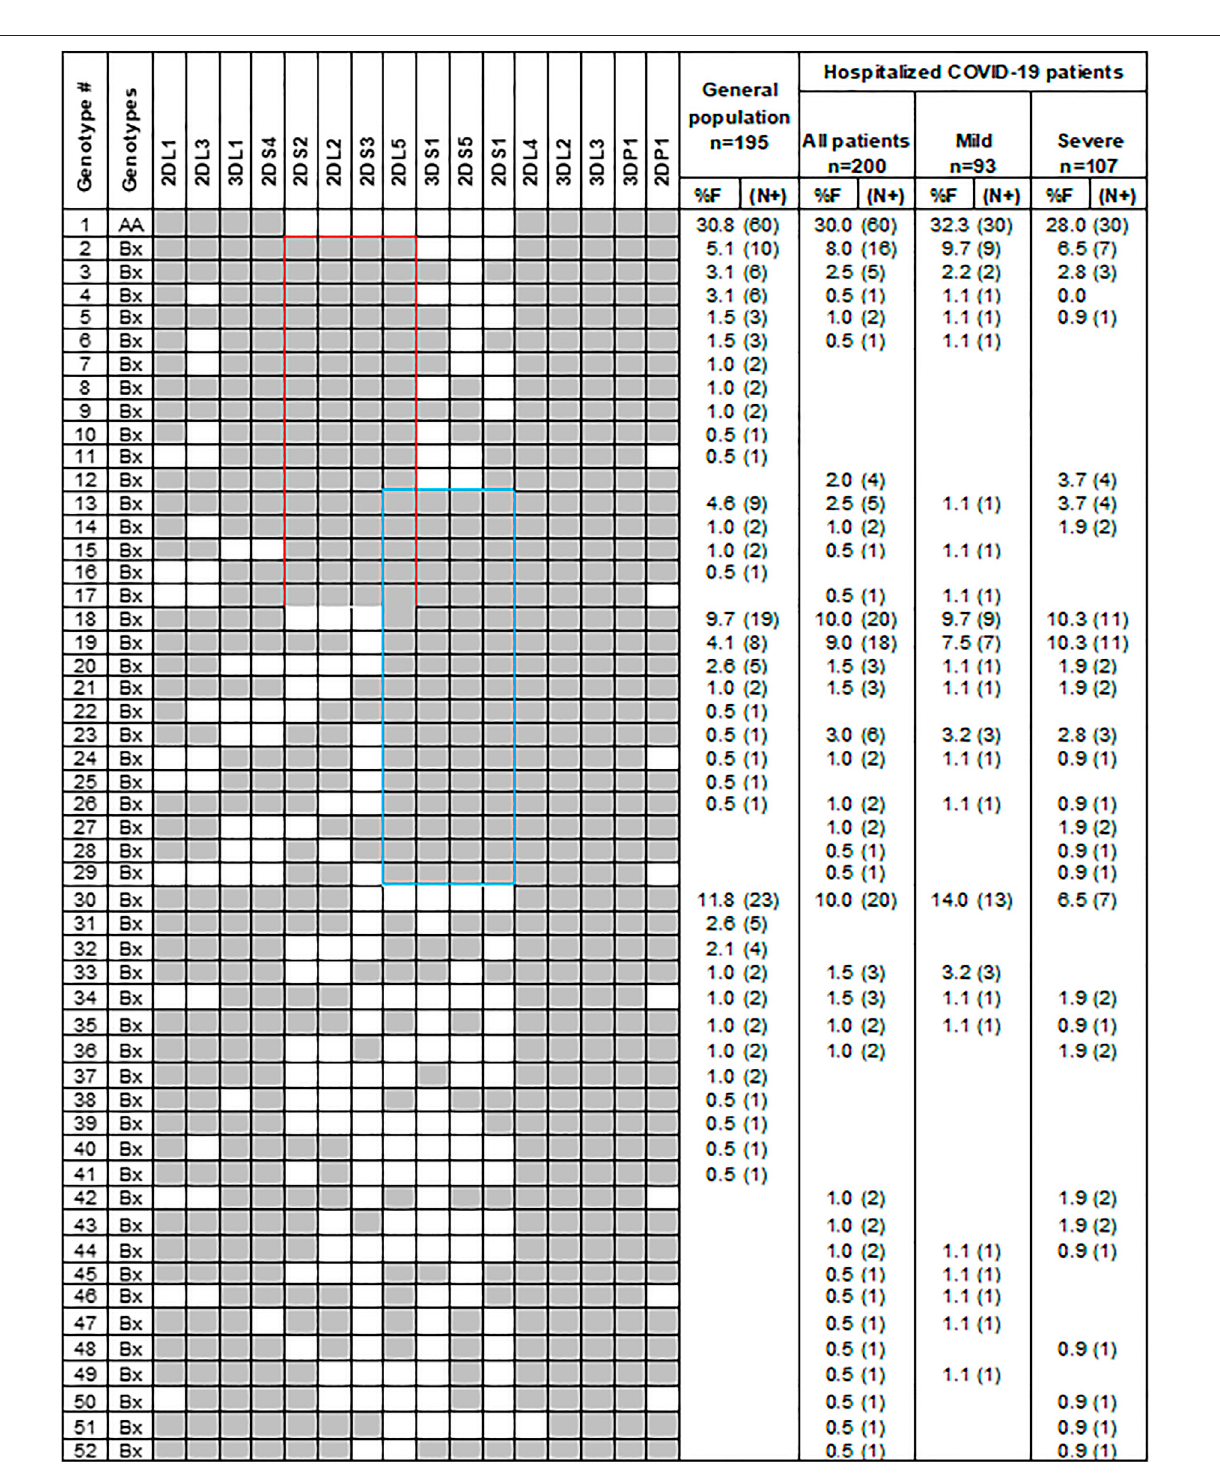
Frontiers in Genetics |